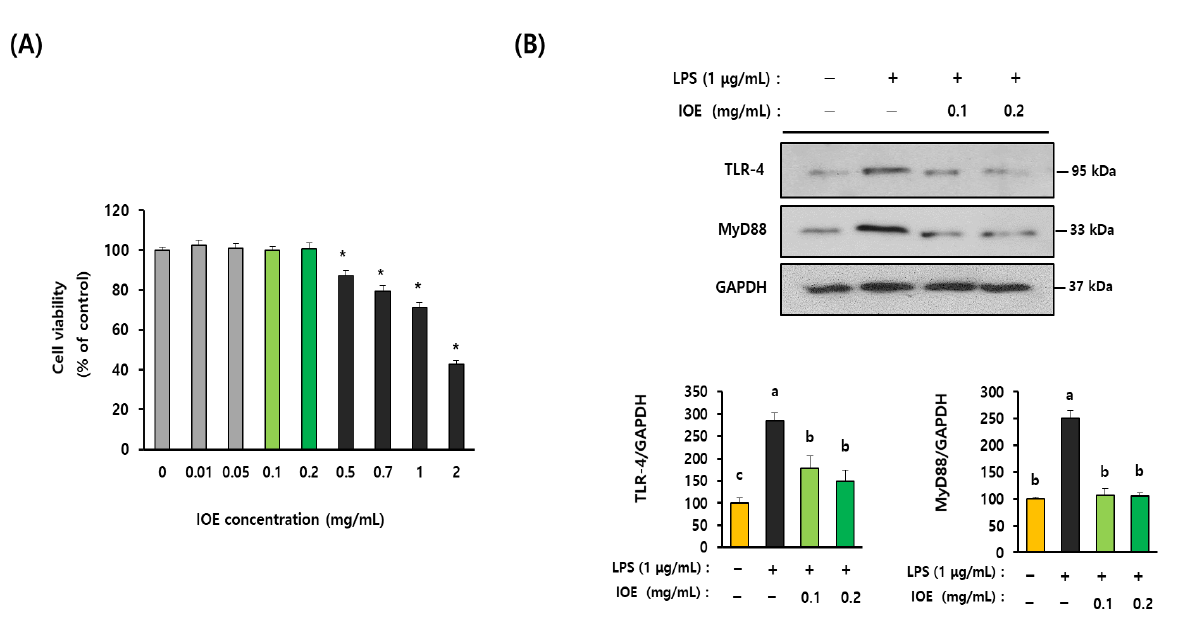
Figure 7. IOE attenuated the expression of TLR-4 and MyD88 in LPS-treated C6 glioma cells. Cyto- toxicity of IOE on the C6 glioma cells was estimated by using a WST-1 cell viability assay kit ( A ). The expression of TLR-4 and MyD88 on the C6 glioma cells treated with LPS was evaluated by western blotting. The density of each band was calculated by using Image J program and tabulated ( B ). These experiments were conducted at least three times with similar results. Data shown are the mean ± SD and different letters (a–c) indicate the significant differences among treatments ( p < 0.05). Each value is assigned as a, b and c sequentially from the highest value. * indicates significant differences when compared to the control (non-treatment) p < 0.05.